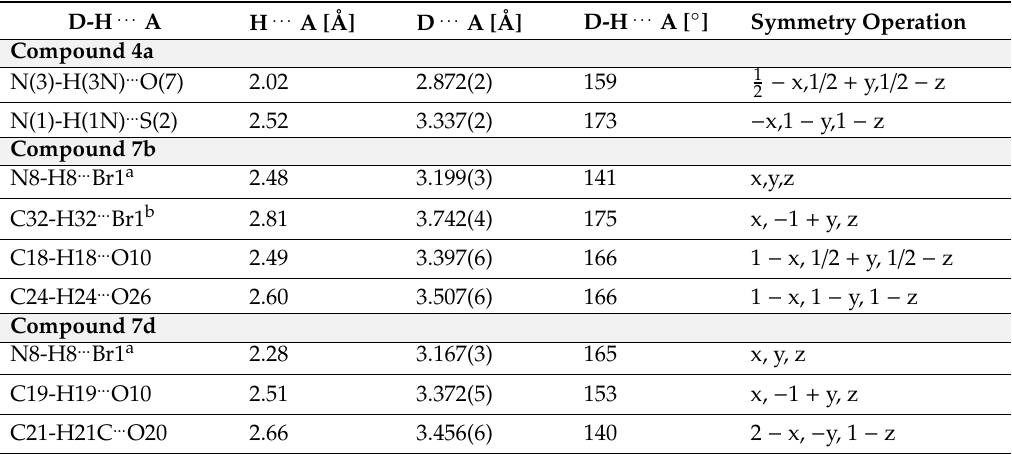
a —classical hydrogen bond. b —for reasons of clarity these contacts are not represented in Figure 5. a — classical hydrogen bond. b — for reasons of clarity these contacts are not represented in Figure 5.